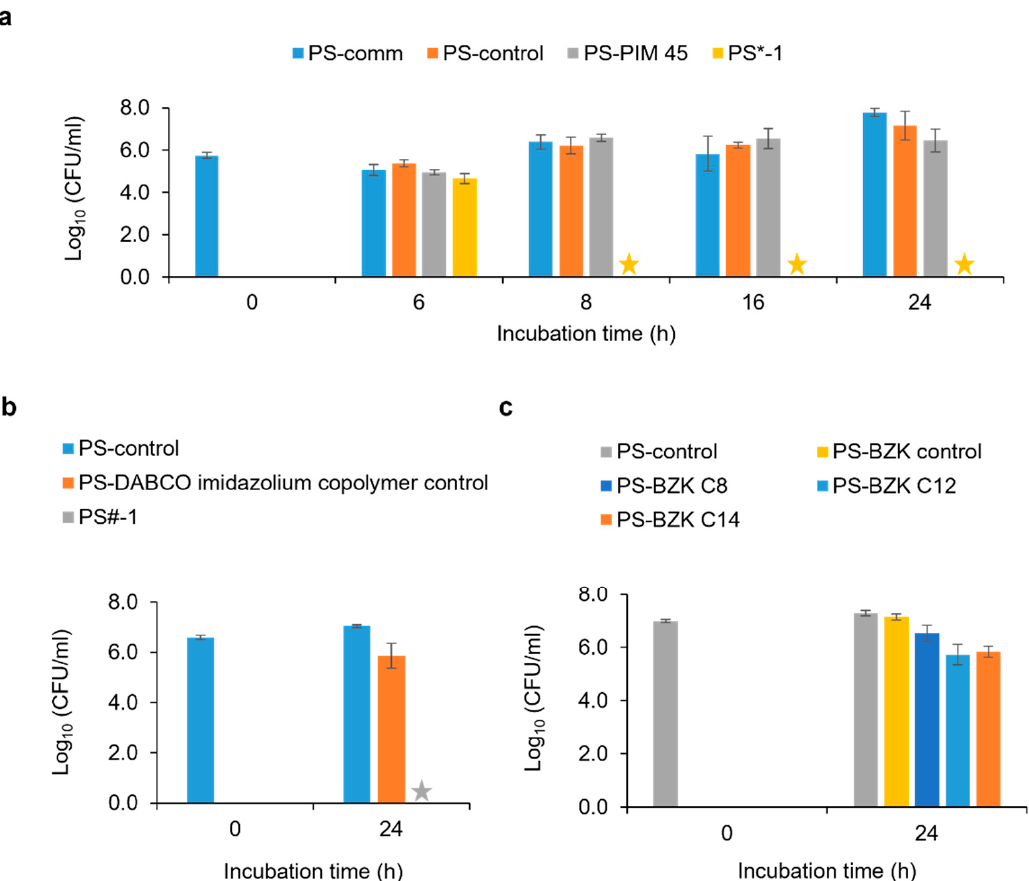
Figure 3. Antimicrobial assessment of functionalized PS with active components based on JIS Z 2801/ISO 22196 test method. ( a ) Time-kill kinetics of PS*-1 against E. coli with different incubation time; Antimicrobial activities of ( b ) DABCO-imidazolium functionalized PS (PS#-1) and ( c ) PS-BZK C8, C12, and C14 against E. coli . The data are expressed as mean and standard deviations of triplicates. ( ) indicates no colony observed on respective